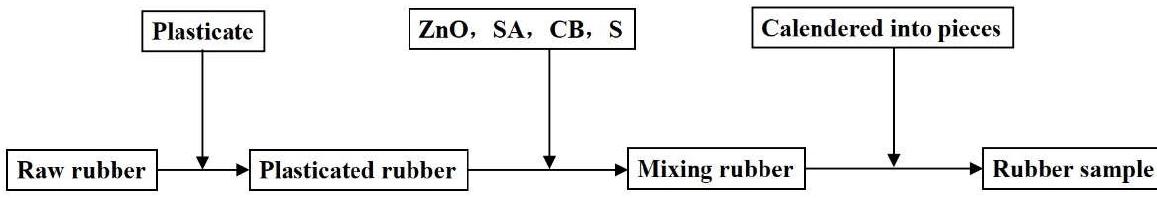
Figure 3. The process flow diagram of the open mixing technology.